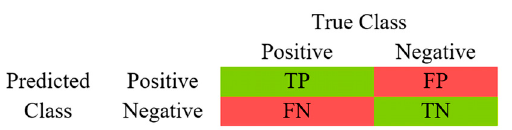
Figure 4. Typical confusion matrix scenario for classification problems.